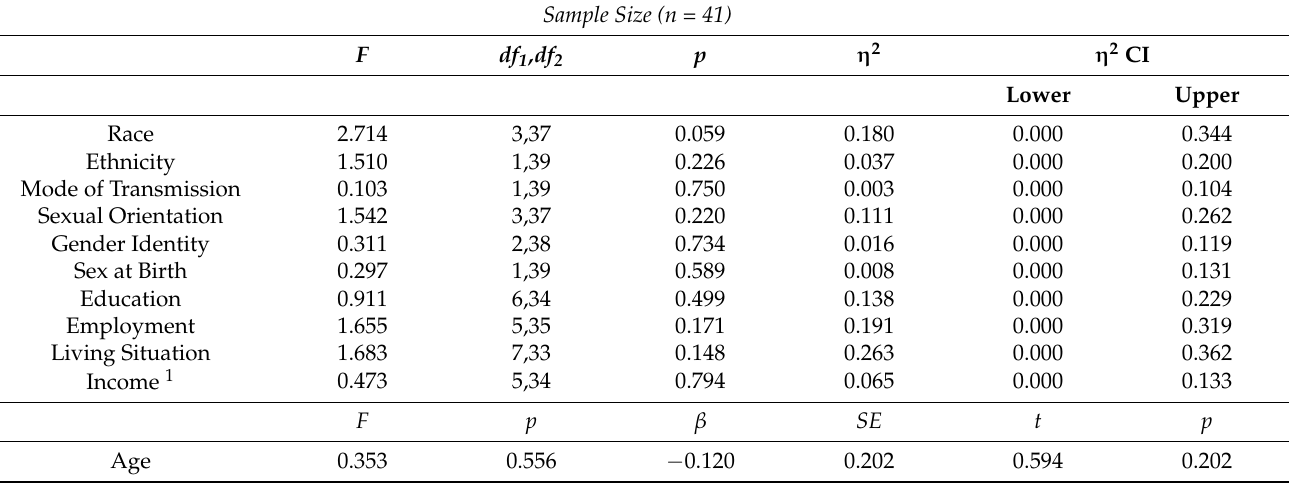
Table 3. Group differences by demographics.